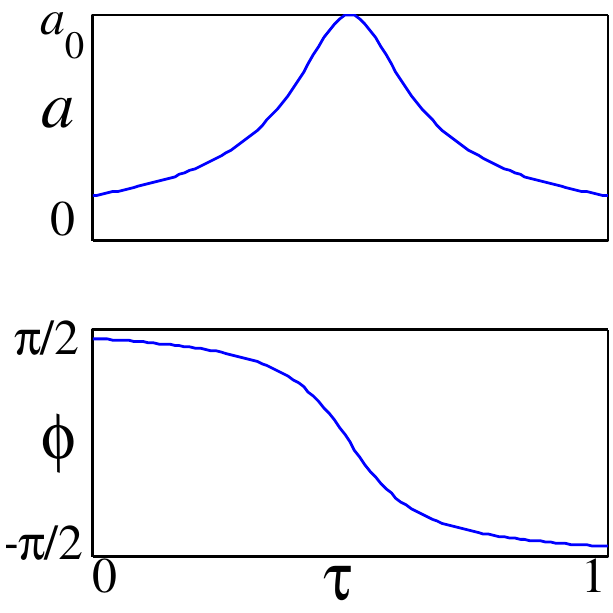
FIG. 2. (Color) Dimensionless optical field amplitude a (cid:3) (cid:3) (cid:5) and phase (cid:4) (cid:3) (cid:3) (cid:5) versus dimensionless time (cid:3) (cid:1) ct=L , for a short- (cid:1) 0 : 1 . Note the rapid change in ampli- Rayleigh length FEL, z 0 tude and phase near the optical waist at the center of the (cid:1) 0 : 5 undulator, (cid:3) (cid:1) (cid:3) w